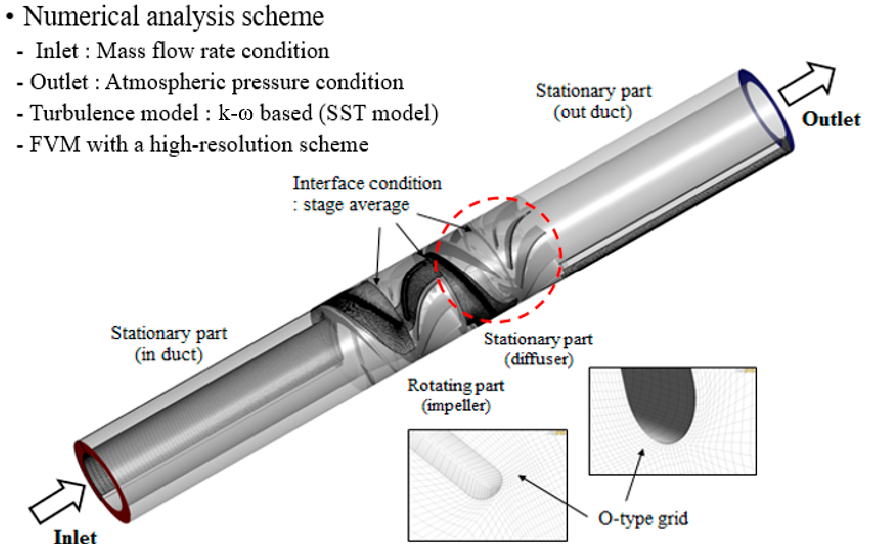
Figure 2. Numerical analysis domain and schemes.